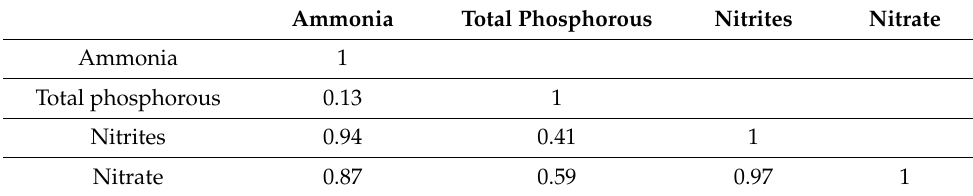
Table 3. Correlations among studied water quality parameters in the raw wastewater. Ammonia Total Phosphorous Nitrites Nitrate Ammonia 1 Total phosphorous